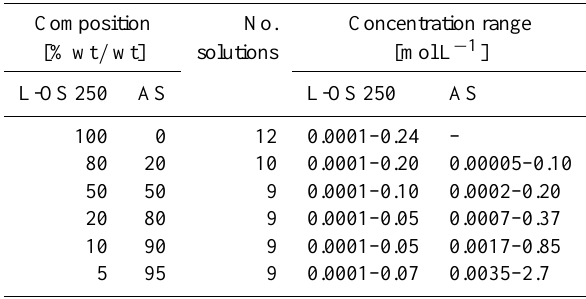
Table 1. Composition and concentration range of the solutions used for surface tension